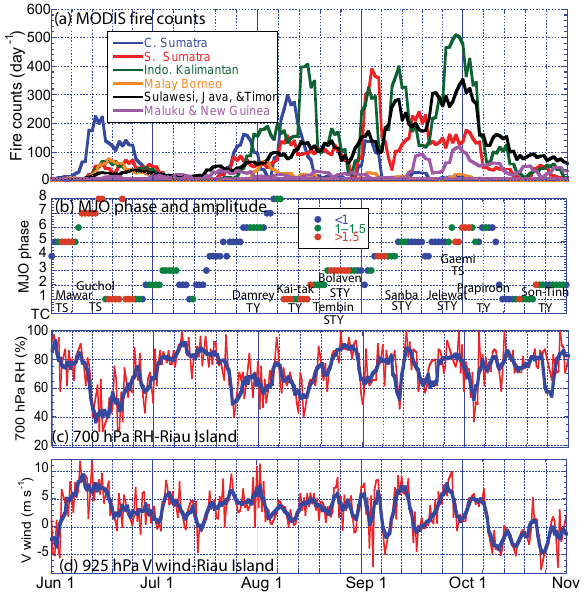
Figure 5. Time series data for the 2012 MC burning season. (a) A 5-day box car average of observed Terra and Aqua combined ac- tive fire hotspot detections for the 2012 Maritime Continent burning season by region as defined in Reid et al. (2012, 2015). (b) Wheeler index of MJO phase and color-coded amplitude, where amplitudes above one are considered statistically significant and above 1.5 as strong. Regional tropical cyclones and categories passing near Lu- zon are also listed (tropical storm – TS; typhoon – TY; super- typhoon – STY). (c) 700hPa RH from radiosondes released at Riau Island in the South China Sea as an indicator of convective activity and/or inhibition. Shown are instantaneous (red) and 3-day boxcar values (blue). (d) Likewise meridional wind at 925hPa at Riau Is- land is an indicator of monsoonal